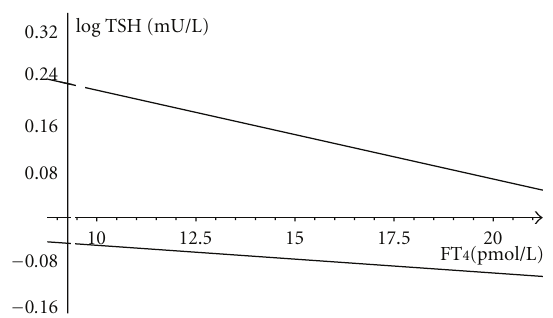
Figure 4: FT 4 adjusted TSH band in the euthyroid range. The linear regression fitted to the euthyroid sample ( n = 150) is described by the equation ( ± SE), log TSH = − 0.014 ( ± 0.006) ∗ FT 4 + 0.36 ( ± 0.1). The lines indicate the upper and lower 2 SD range of the regression